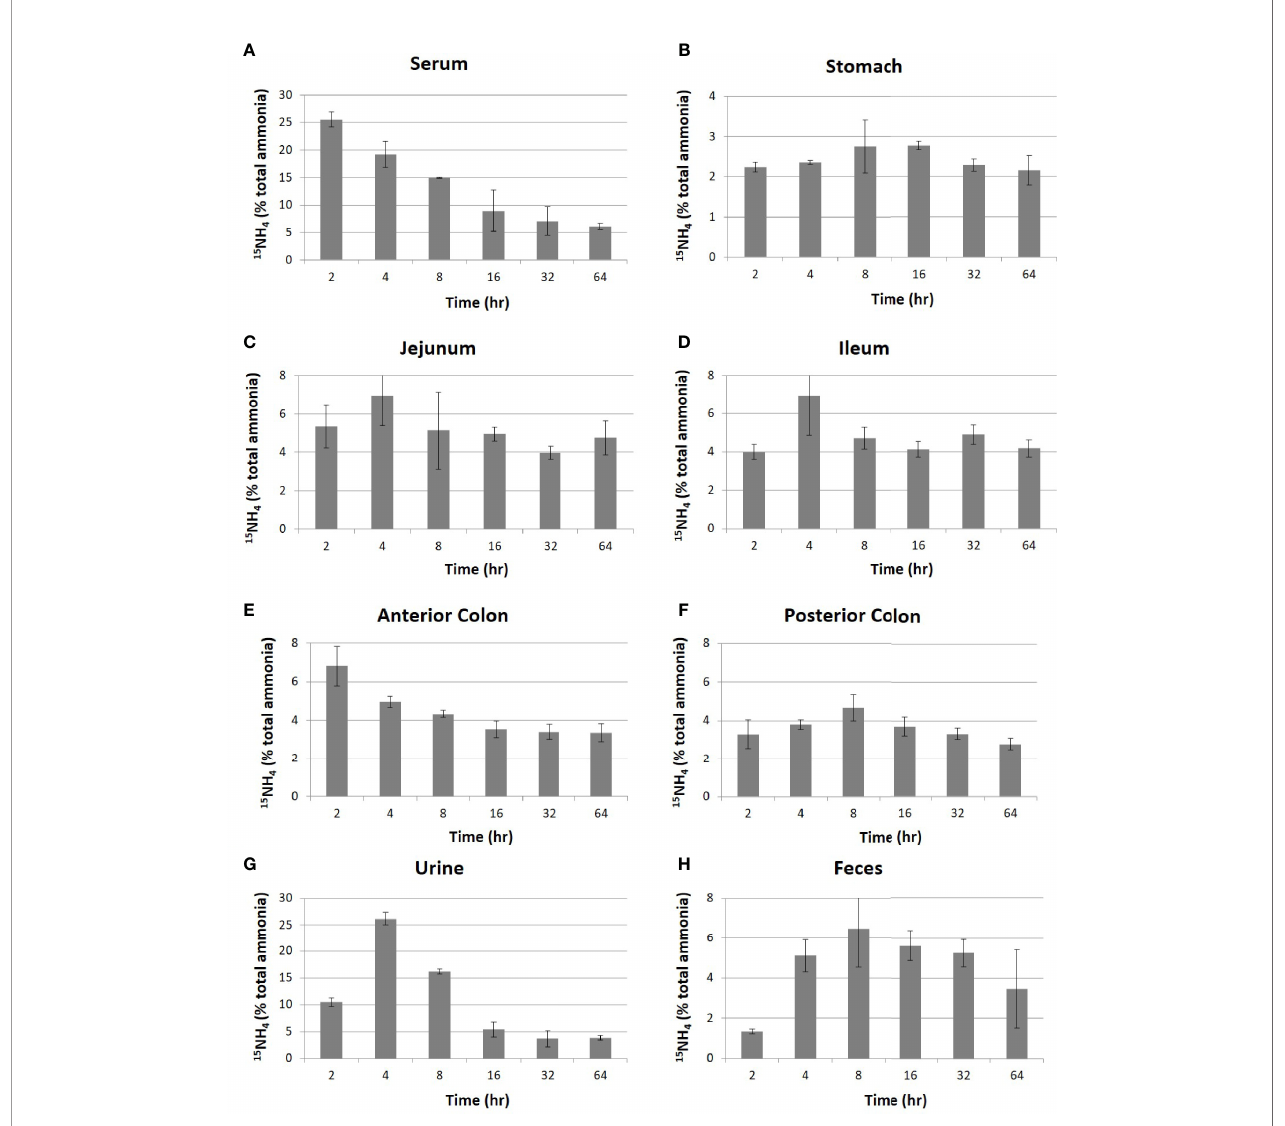
FIGURE 1 | Distribution of intravenously injected 15 NH 4 in mouse organs. After intravenous injection of 15 NH 4 Cl into 4-week-old C57BL/6 mice (n=5 per group) at a dose of 250 mg/kg of body weight, samples of blood, contents of the intestine (jejunum and ileum), contents of the colon (anterior colon and posterior colon), urine, and feces were collected at the indicated time. The migration of 15 NH was traced by analyzing with high-resolution LC-MS/MS in serum (A) , stomach (B) , jejunum (C) , ileum (D) , anterior colon (E) , posterior colon (F) , urine (G) , and feces (H) . The quantities in Y-axis were represented in a relative quantity of 15 NH 4 in total ammonia. All data were expressed as the mean ± SD, as